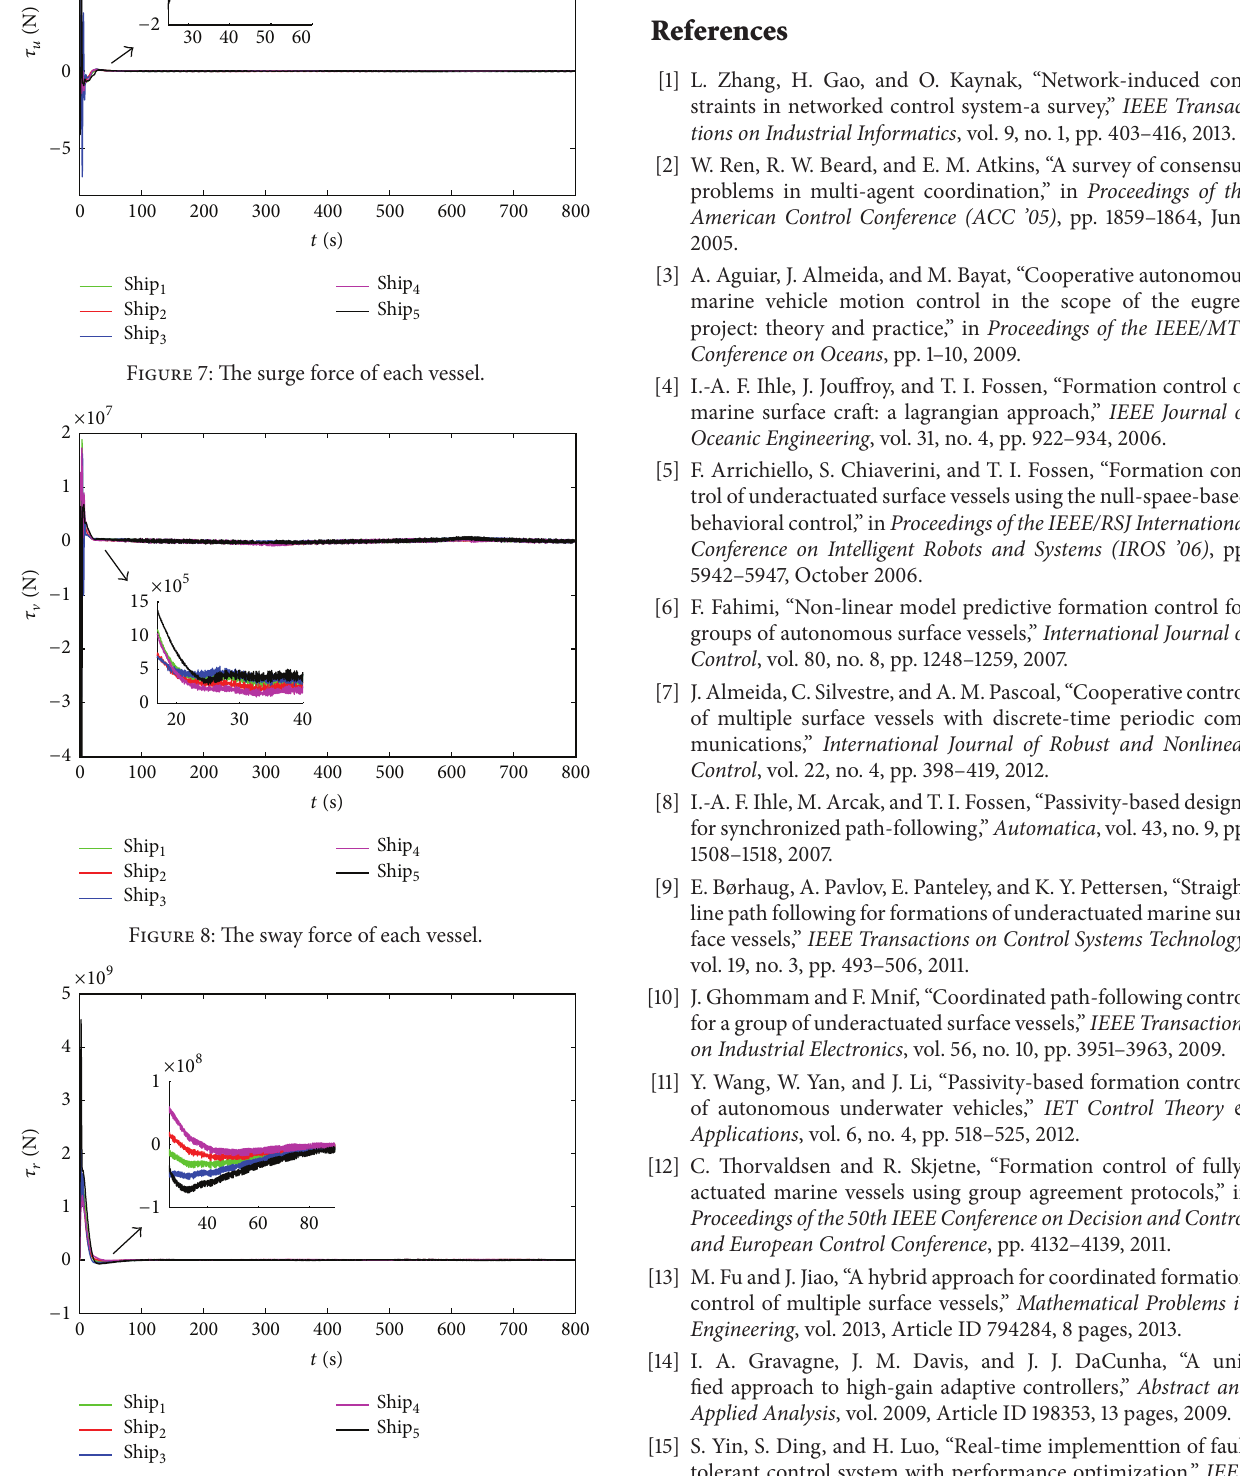
Figure 9: The heave force of each